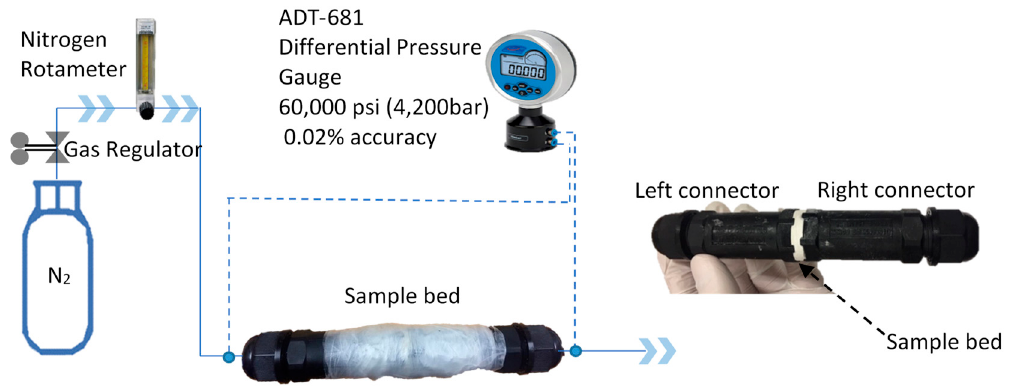
Figure 3. Workbench for permeability tests.